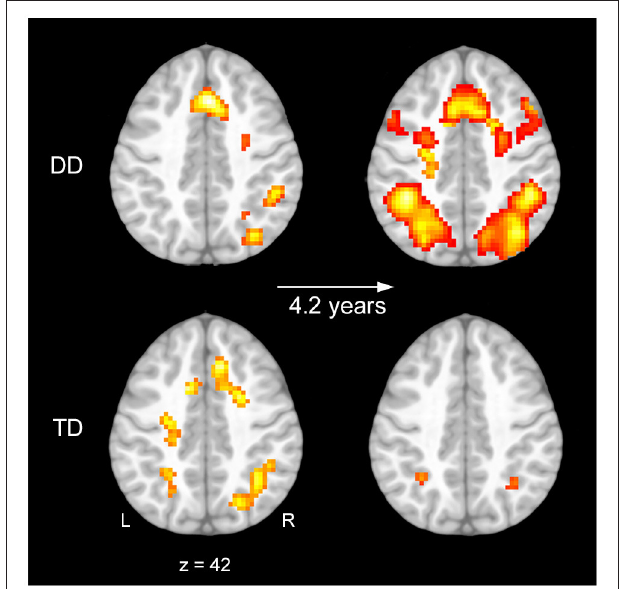
FIGURE 3 | Activation at baseline and follow-up. Task related brain activation shown on a pediatric template (Fonov et al., 2009, 2011) for the contrast numerical order vs. control task at baseline (Left) and follow-up (Right) for children with developmental dyscalculia (DD) (Upper) and typically developing (TD) children (Lower) ( p < 0.01, k ≥ 24, cluster-extent corrected).